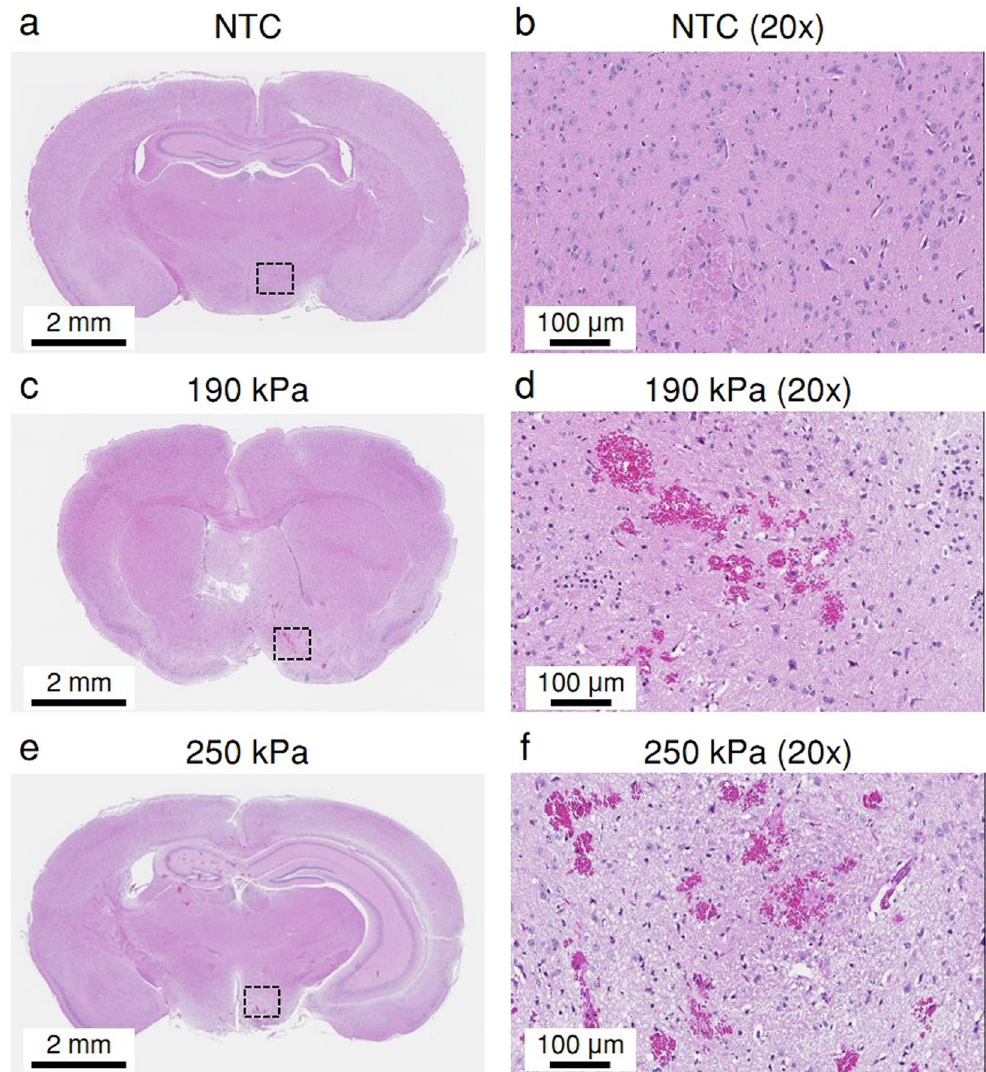
Figure 9. Histological photomicrographs obtained 1 hour post treatment. ( a ) No treatment control (NTC). ( b ) 20x magnification of the dashed black square area in a. ( c ) MBs + 190 kPa peak negative pressure (PNP) ultrasound. ( d ) 20x magnification of the dashed black square area in c. ( e ) MBs + 250 kPa PNP ultrasound. ( f ) 20x magnification of the dashed black square area in